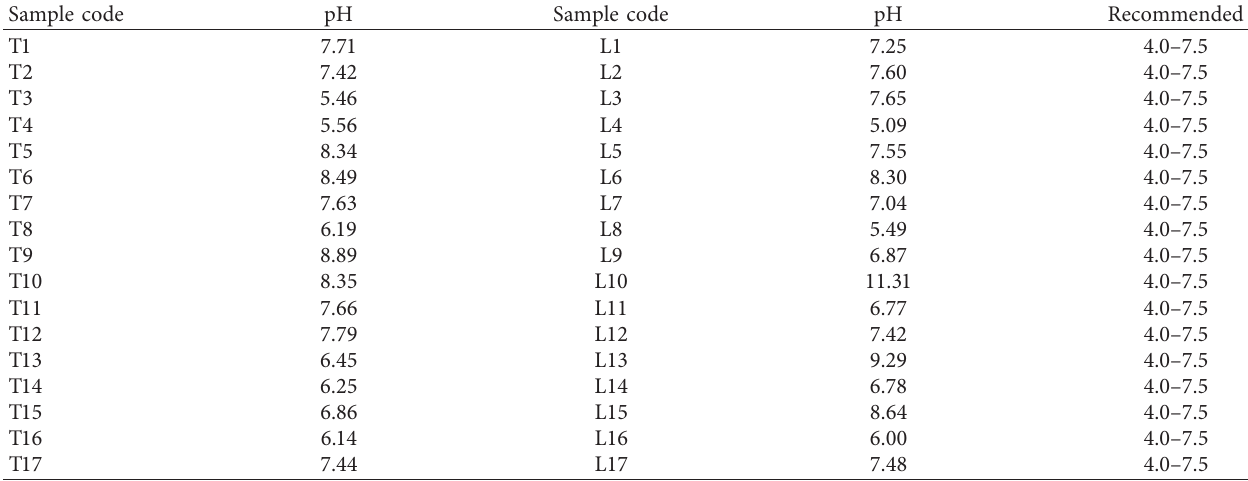
Table 3: pH of fabrics from store A and store B and the Oeko-Tex recommended values.